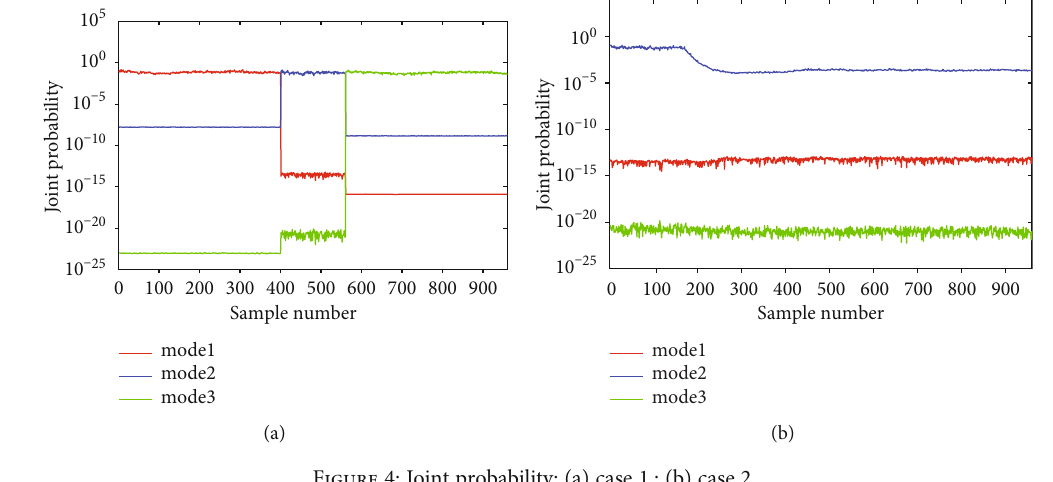
Figure 4: Joint probability: (a) case 1.; (b) case 2.. Table 2: Comparison of fault detection accuracy